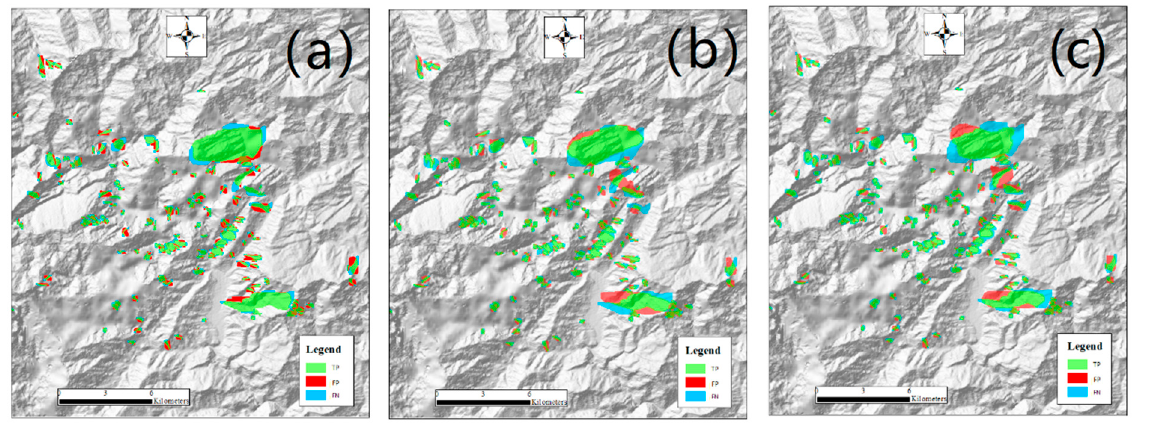
Figure 9. Detection results of U-Net models with sample set S10000 around the Daguangbao landslide: ( a ) UNet − ; ( b ) UNet+; ( c ) ResUNet. The blurred part in the southwest is a defect of the original DEM, not related to the detection result.